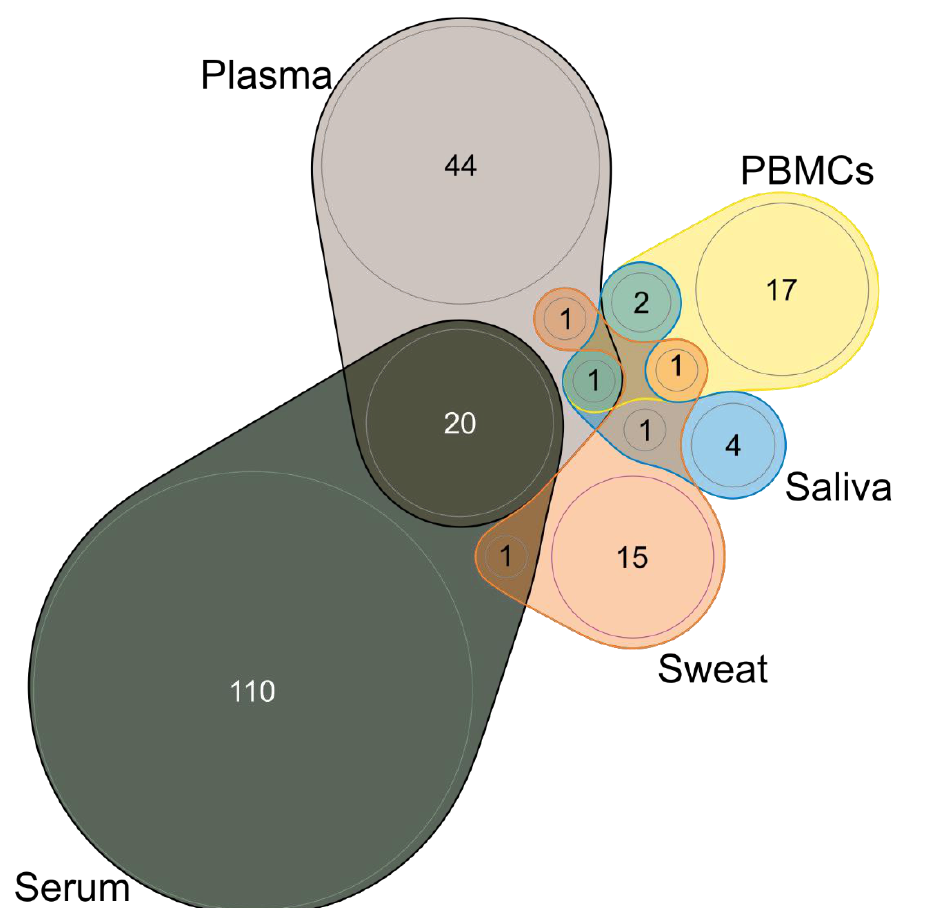
Figure 4. Venn diagram of the 217 proteins identified as altered in the human peripheral fluids serum, plasma, PBMCs, saliva and sweat in the selected studies of schizophrenia (SCZ) vs. control. The proteins identified as altered in: (i) only serum: 110 proteins; (ii) only plasma: 44 proteins; (iii) only PBMCs: 17 proteins; (iv) only saliva: 4 proteins; (v) only sweat: 15 proteins; (vi) plasma vs. PBMCs vs. saliva: 1 protein; (vii) plasma vs. serum: 20 proteins; (viii) plasma vs. PBMCs: 1 protein; (ix) plasma vs. sweat: 1 protein; (x) serum vs. sweat: 1 protein; (xi) PBMCs vs. sweat: 1 protein; (xii) PBMCs vs. saliva: 1 protein; (xiii) sweat vs. saliva: 1 protein.